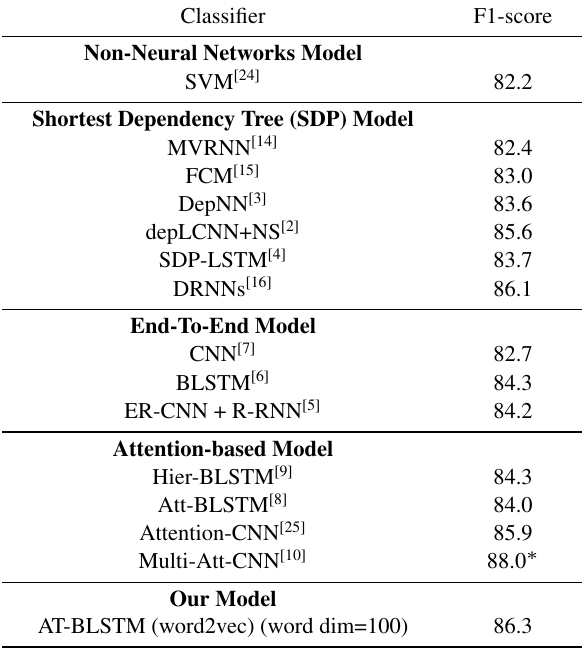
Table 2 Comparison with previous results on SemEval 2010 task 8